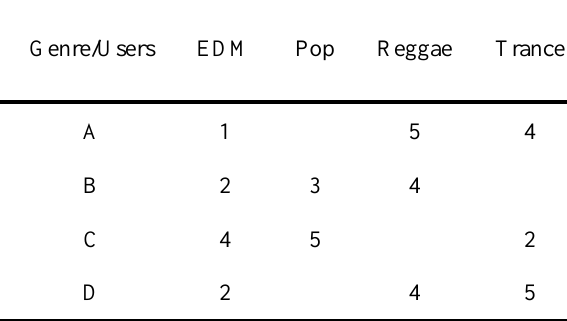
Table 5. Ratings based on collaborative